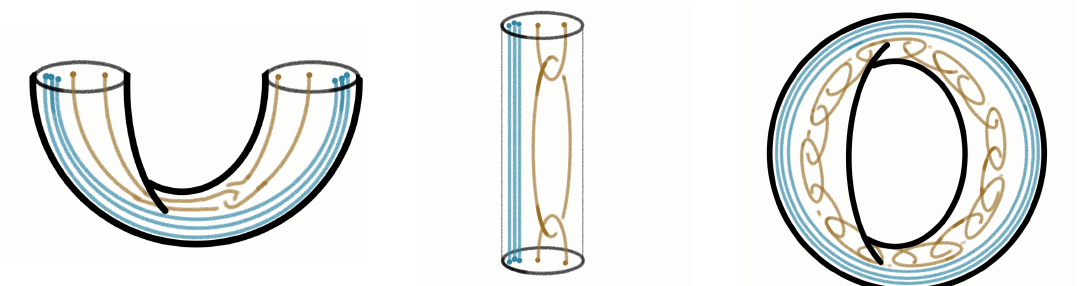
Figure 1. A state with two “chained” Wilson lines for an arbitrary number of punctures ( left ). The reduced density matrix of the corresponding state ( center ). S 2 × S 1 of a chain link that computes tr ( ρ A ) n ( right ). See [9] for a particular